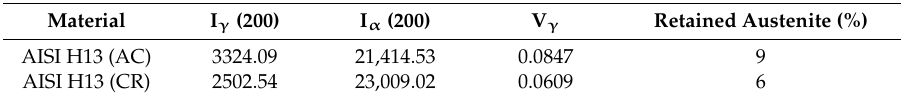
Figure 11. XRD patterns of sample AISI H13 in the CR condition. Table 7. Integrated intensity of austenite and ferrite in plane (200), and the volume fraction of retained